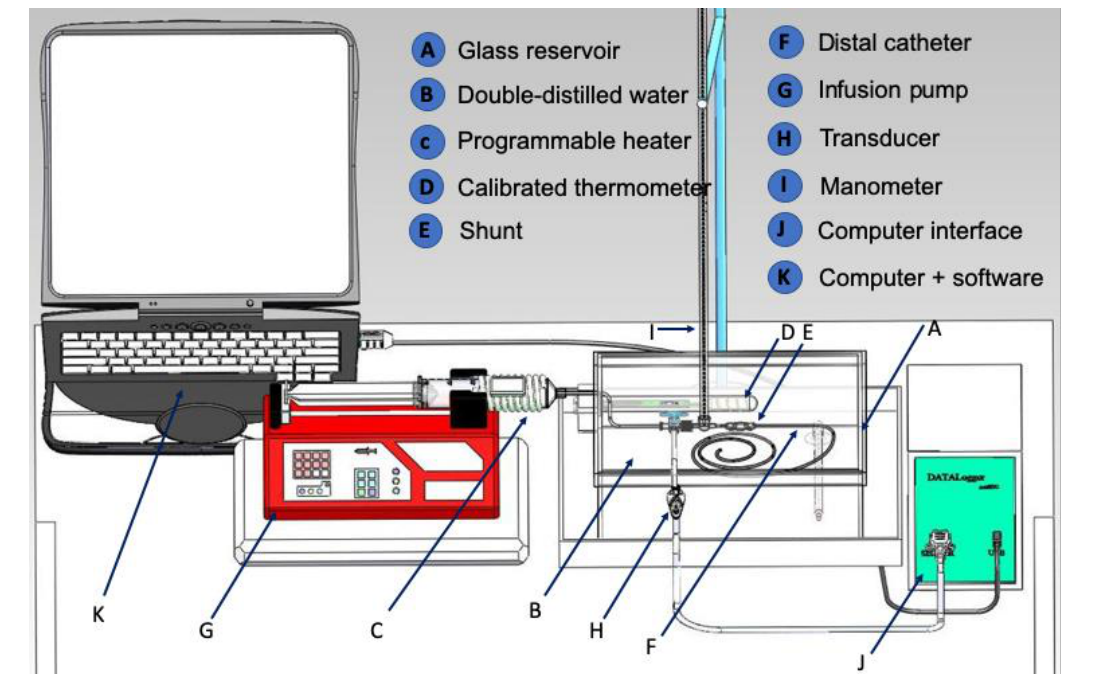
Figure 1 - Bench test for pressure-flow shunt graph